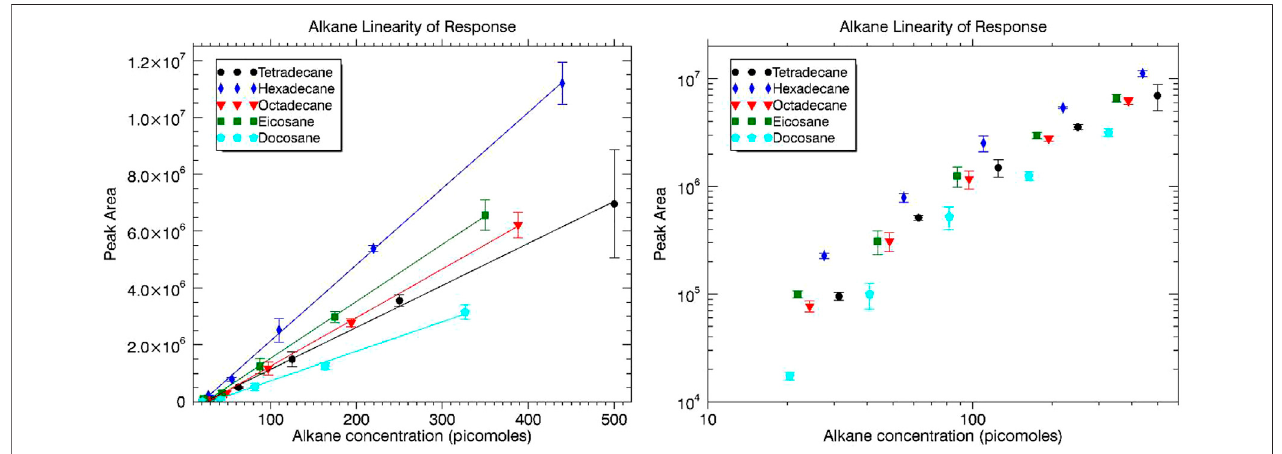
TABLE 1 | Extrapolated limits of detection (LODs) for the alkanes on the MEMS GC-MS experimental setup.